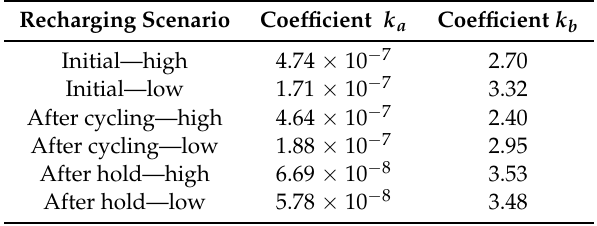
Table 2. Calculated leakage current model parameters for different recharging scenarios based on results given in [18].